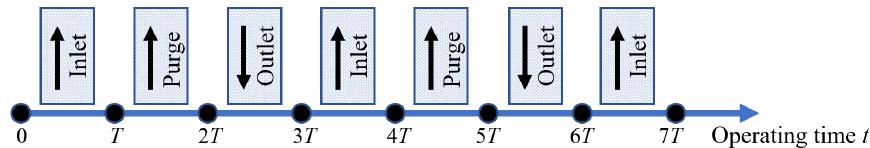
Figure 3. Operating profile of a certain canister (where T is the valve switch time).